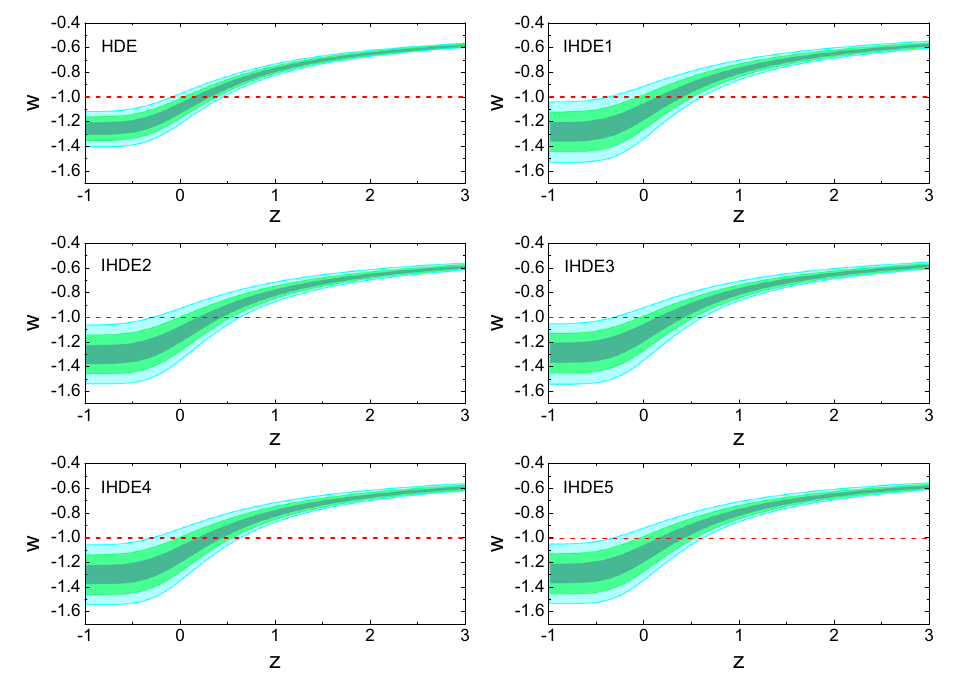
Fig. 6 The reconstructed evolution of w (with 1–3 σ errors) for the HDE model and the five IHDE models. The red dashed line denotes the cosmological constant boundary w = − 1 [112],itwasshownthattheIHDE5( Q = 3 β H